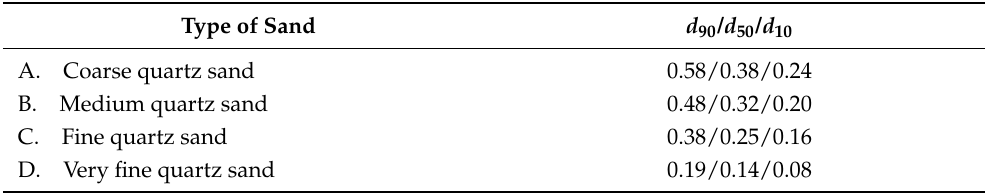
Table 2. Granulometric characteristics of the studied sands.